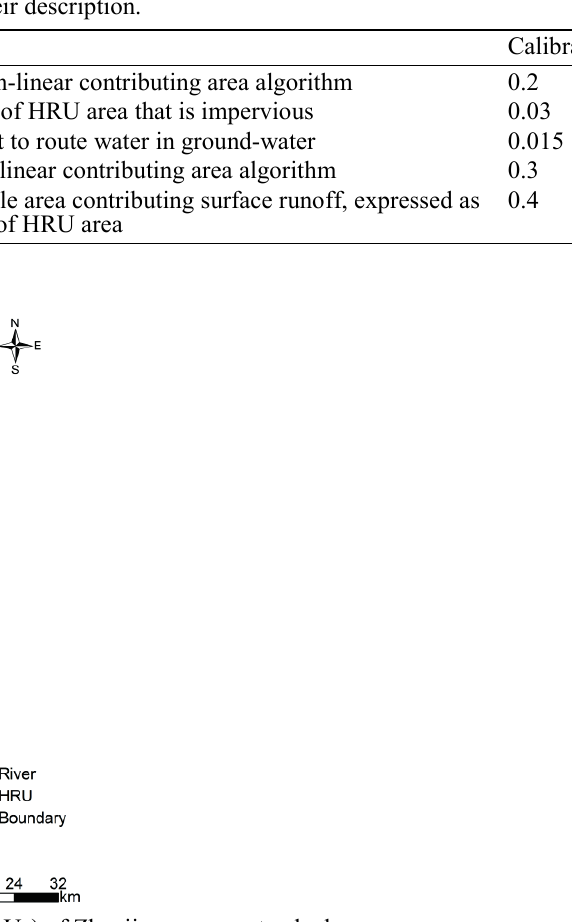
Fig. 2 Hydrologic response units (HRUs) of Zhenjiangguan